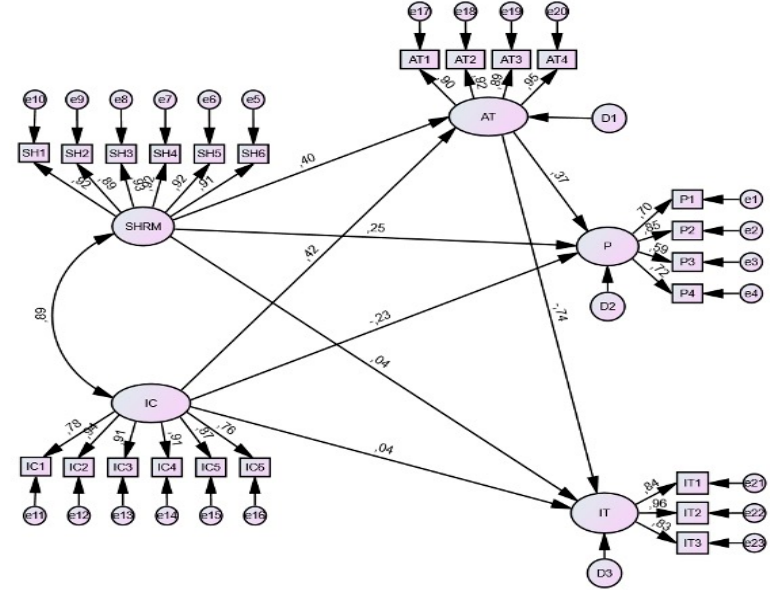
Figure 1. Theoretical model of analysis. Note: this figure was built based on the data retrieved for